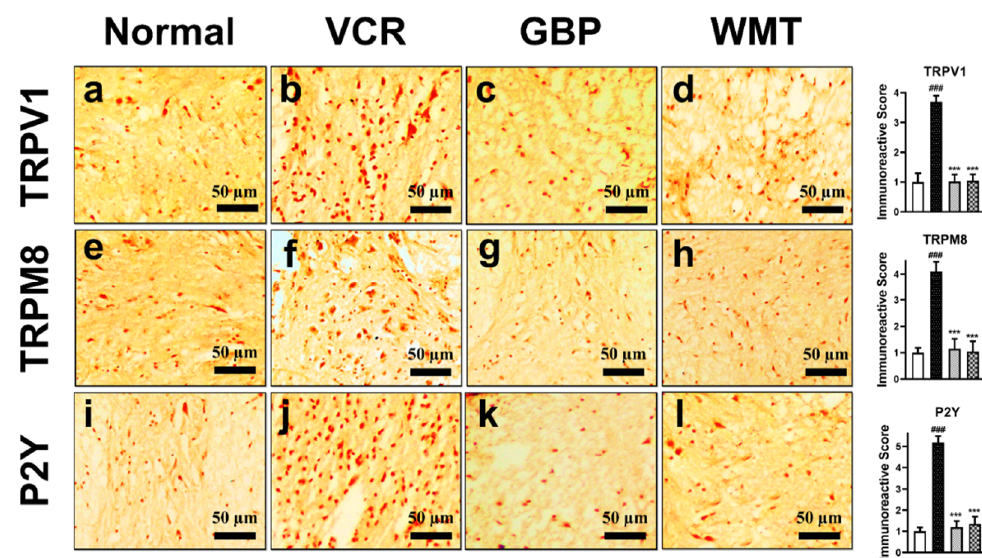
Figure 12. Effect of the withametelin treatment on the expression levels of the TRPV1/TRPM8/P2Y proteins in the mouse spinal cords. Magnification 10×. TRPV1 ( a – d ), TRPM8 ( e – h ), and P2Y ( i – l ). All the results were expressed as the mean ( n = 3) ± SD. ### p < 0.001 vs. the control group. *** p < 0.001 vs. the VCR group.